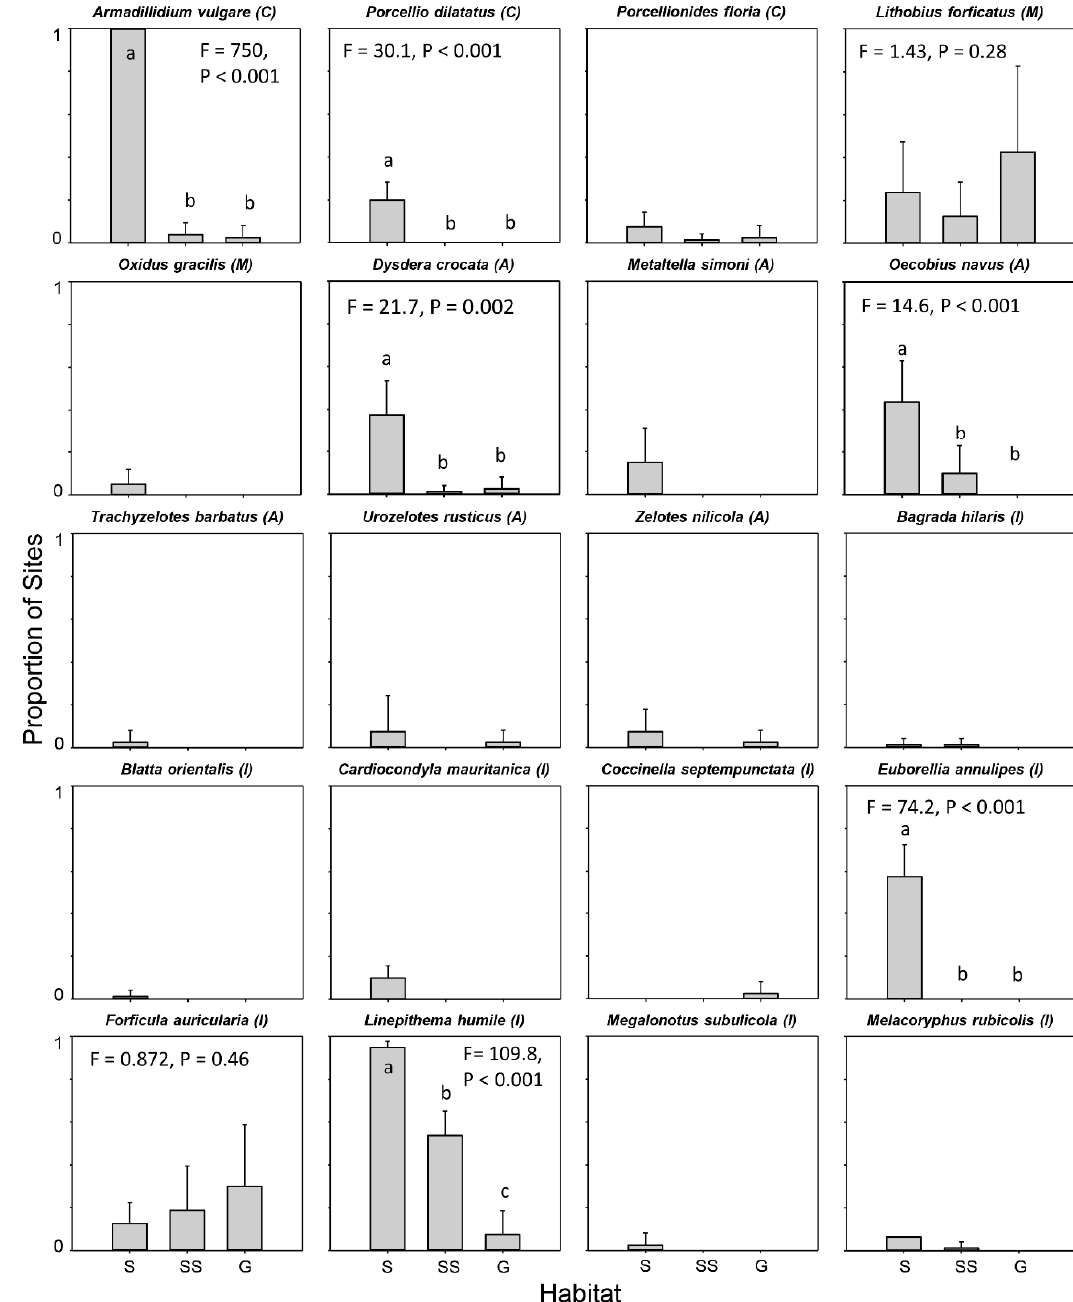
Figure 1. Site occupancy for each non-native species. Bar height is the mean proportion of sites occupied in each habitat type (S = Suburban; SS = Sage scrub; G = Grassland) over the five sampling periods. Error bars show standard deviation. Pseudo-F statistics and P-values from PERMANOVA tests are reported for those species that were collected in at least 18 sites over the 5 sampling periods. Letters on or above bars indicate significantly di ff erent means based on pair-wise comparisons. Letters next to species names indicate subphylum or class: C = Crustacea; M = Myriapoda; A = Arachnida; I =